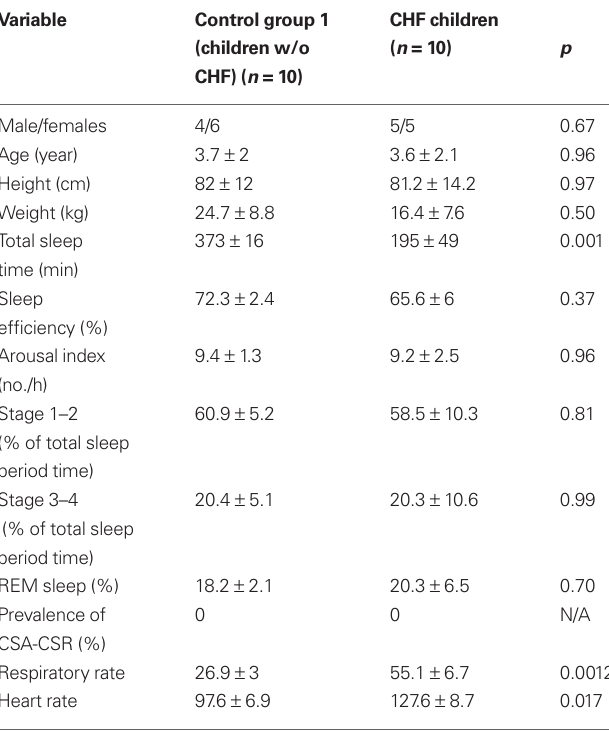
Table 3 | Baseline characteristics and polysomnographic characteristics of the pediatric patients according to their group.